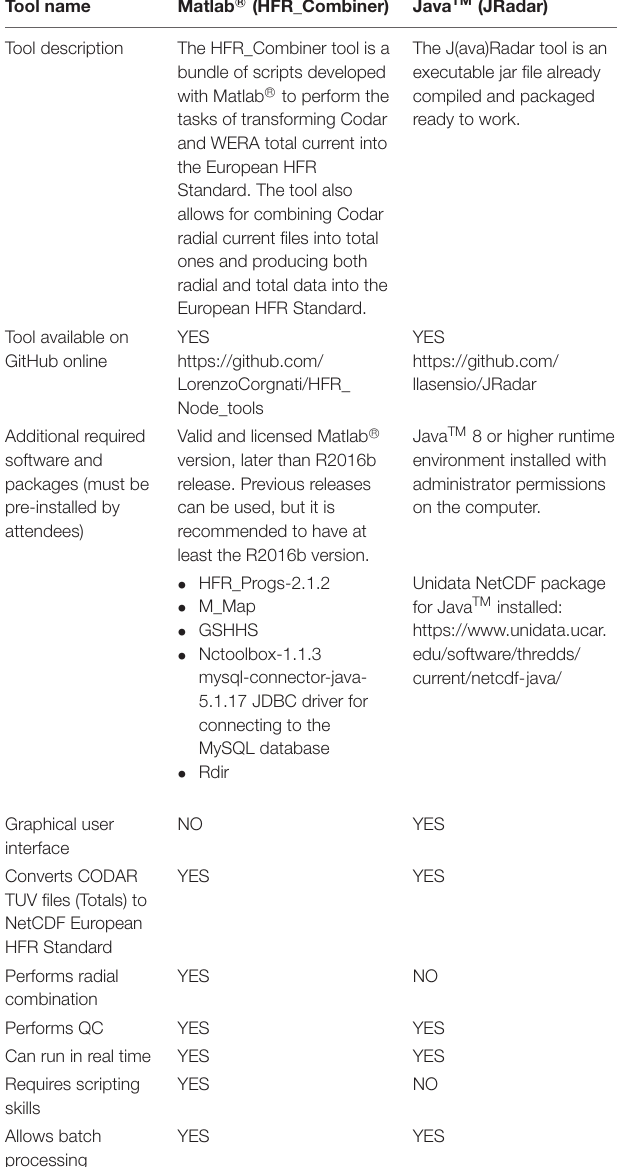
TABLE 10 | Software for data post-processing for European common HFR data and metadata